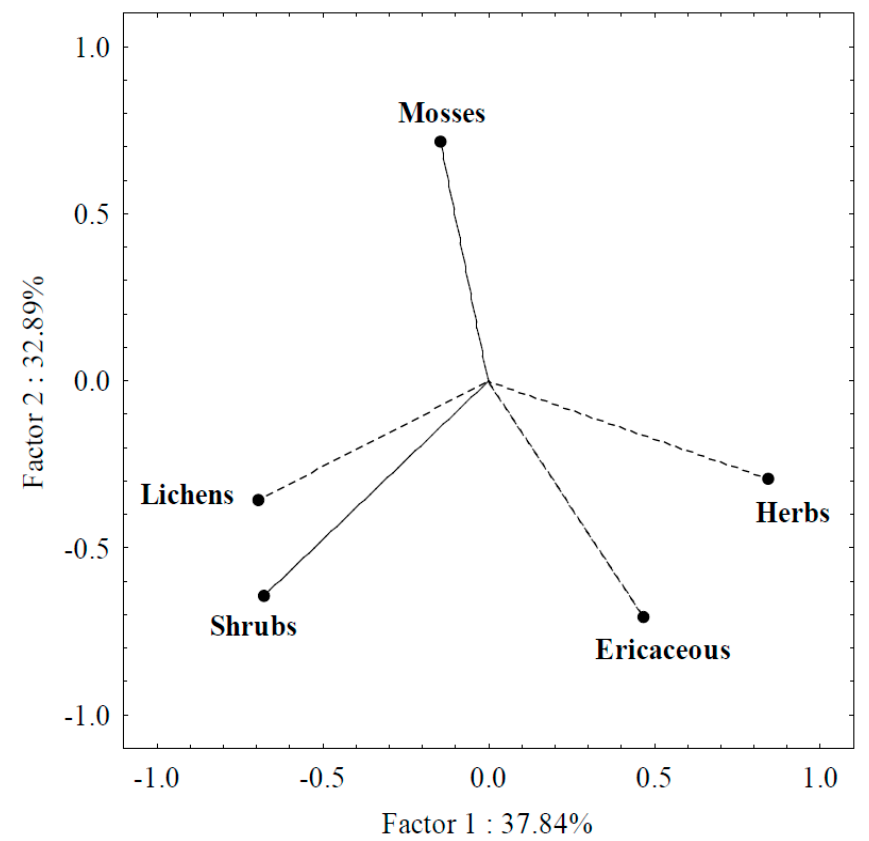
Figure 4. Principal component analysis (PCA) of the functional groups among the postfire sites. Only variables are shown to facilitate reading. Factor cases are shown at Figure 5.